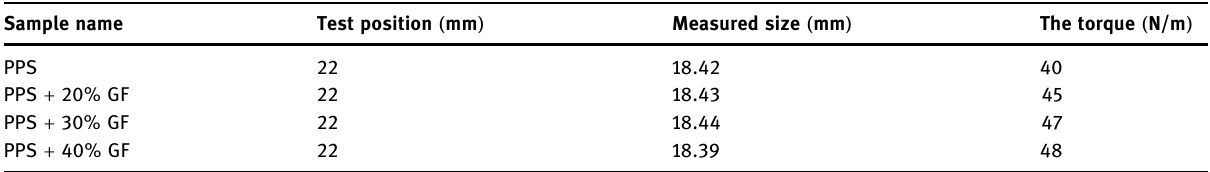
Table 2: Test results of polymer plastic sleeve on spanner tool surface Sample